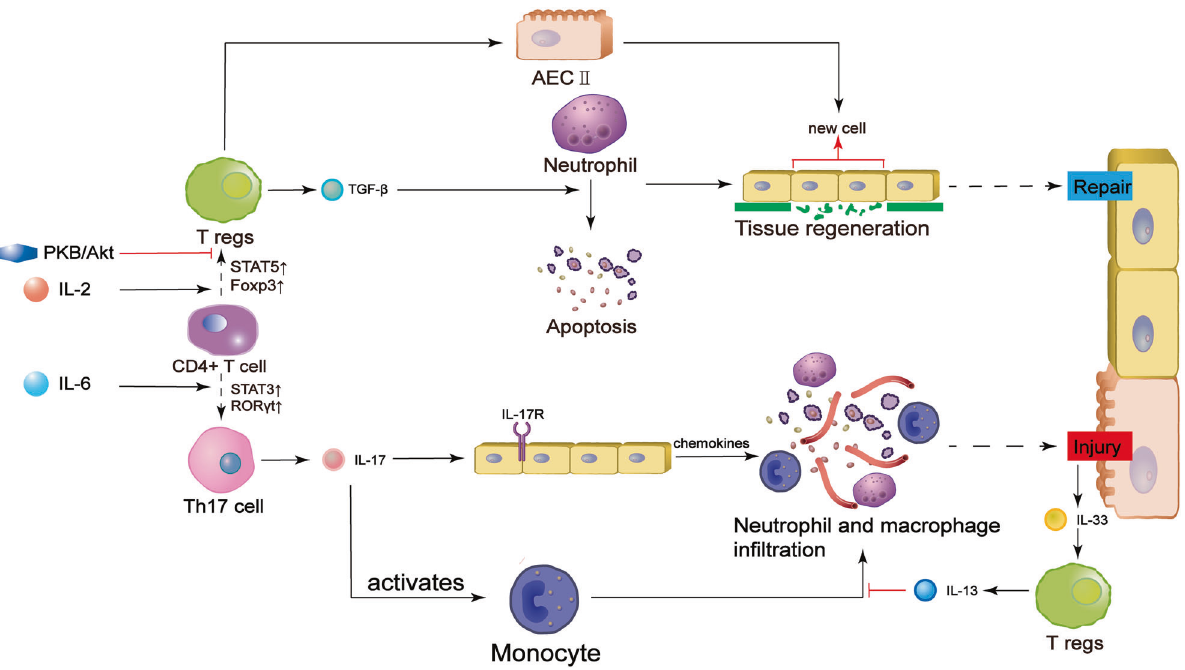
Fig. 1 Role of T cells in ALI. Under the effects of various cytokines, CD4 + T cells differentiate into different cell types. IL-2 initiates the transcription of STAT5 and Foxp3 to induce Treg conversion, while IL-6 is necessary for the activation of Th17 cell-speci fi c transcription factors. In addition, PKB/Akt acts intracellularly to prevent Treg differentiation. Tregs secrete TGF- β , inducing neutrophil death or preventing neutrophil extravasation. Tregs also stimulate the proliferation and differentiation of type II alveolar cells (AECII) to achieve direct repair of the alveolar epithelium. In contrast, Th17 cells produce IL-17 and exacerbate in fl ammation by inducing neutrophil in fi ltration and monocyte maturation. The role of monocytes in ALI is also inhibited by Tregs. IL interleukin, TGF tissue growth factor, STAT signal transducer and activator of transcription, ROR γ t retinoid-related orphan nuclear receptor γ t, Foxp3 forkhead box protein